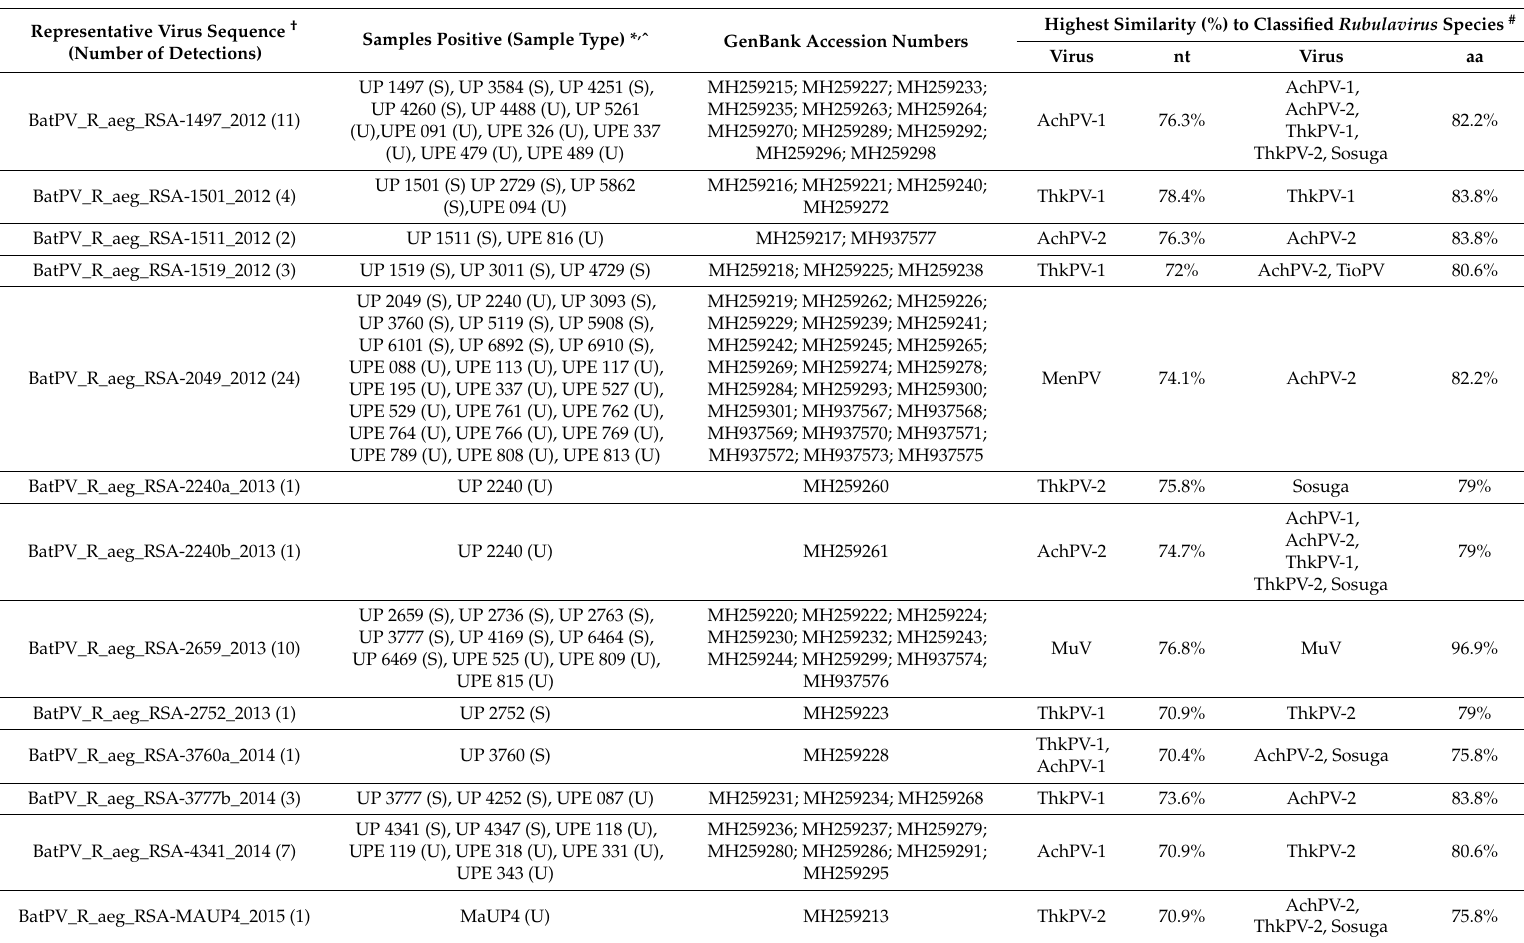
Table 1. Representative sequences for the multiple rubulaviruses detected and partial polymerase gene sequence identity comparison between viral sequences detected in Rousettus aegyptiacus and officially characterized Rubulavirus